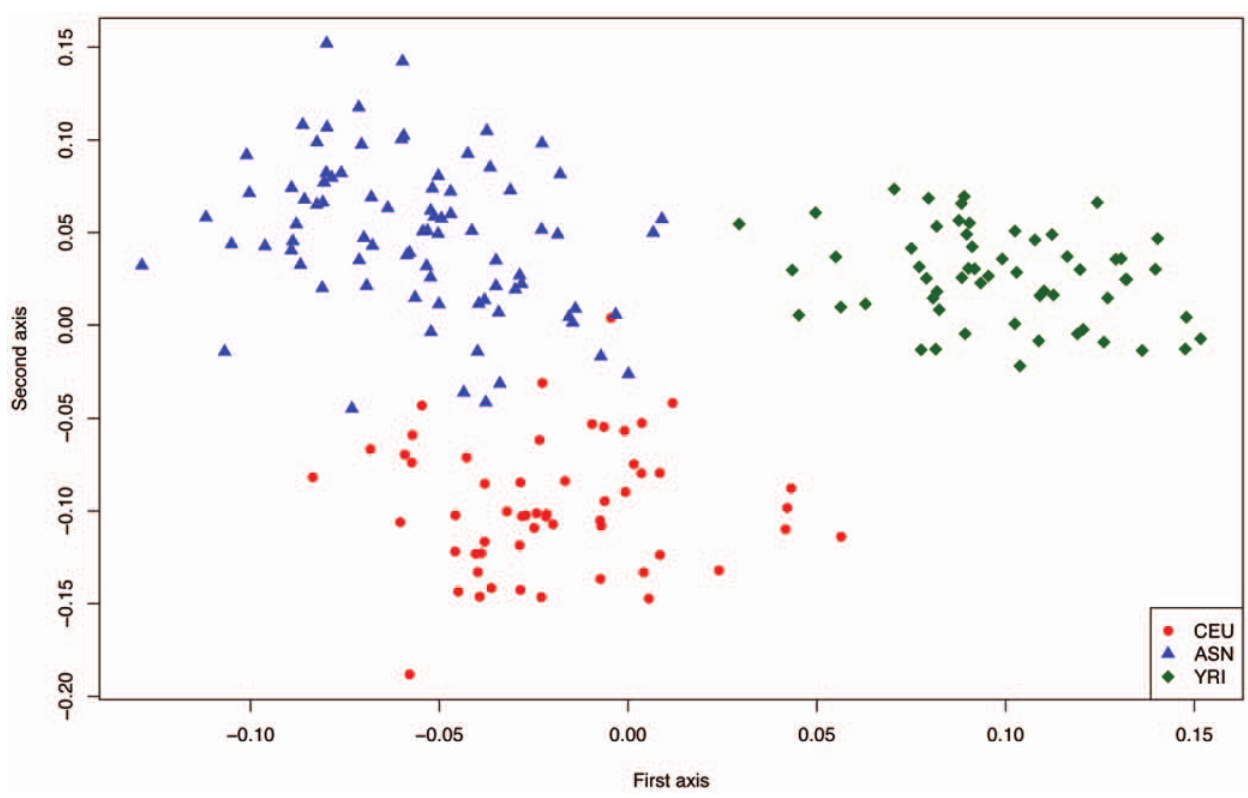
Figure 2. Principal component analysis of MLPA data in HapMap populations. We decomposed the genetic variation within MLPA- estimated copy number into the first two principal axes [56], plotted each data point, and colored them according to the population of origin. Thirty percent of the total variance is explained by the two first principal components (PC1 16,62%, and PC2 13,38%), and it is evident that the first principal component discriminates variation inherent to the population of African ancestry (YRI), while the second component differentiates the populations of European (CEU) and Asian (ASN) ancestries.